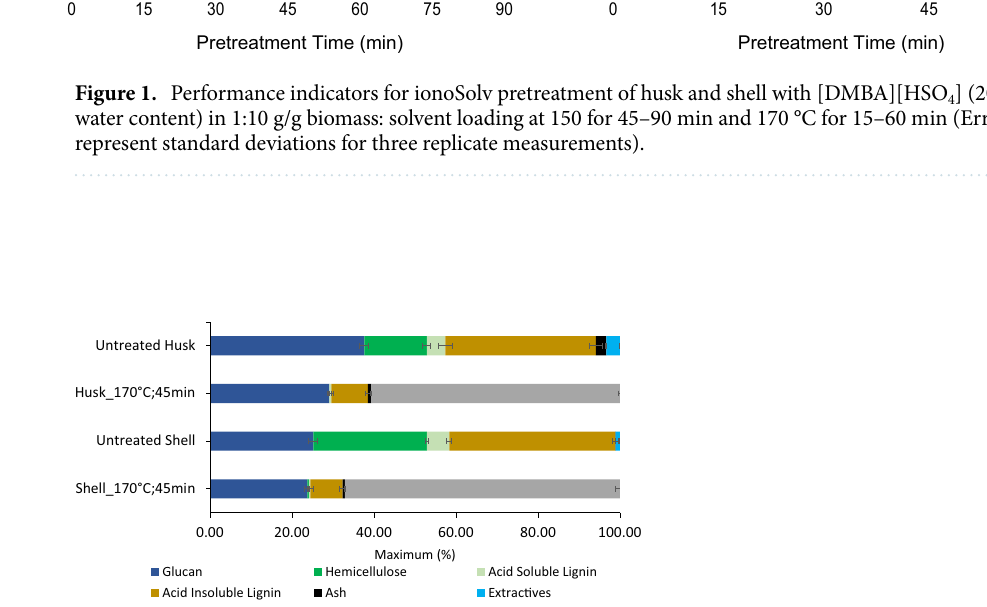
Figure 2. Chemical composition of untreated and pretreated shell and husk pulps before and after pretreatment with [DMBA][HSO 4 ] ILs at optimum temperature and time conditions (Error bars represent standard deviations for three replicate